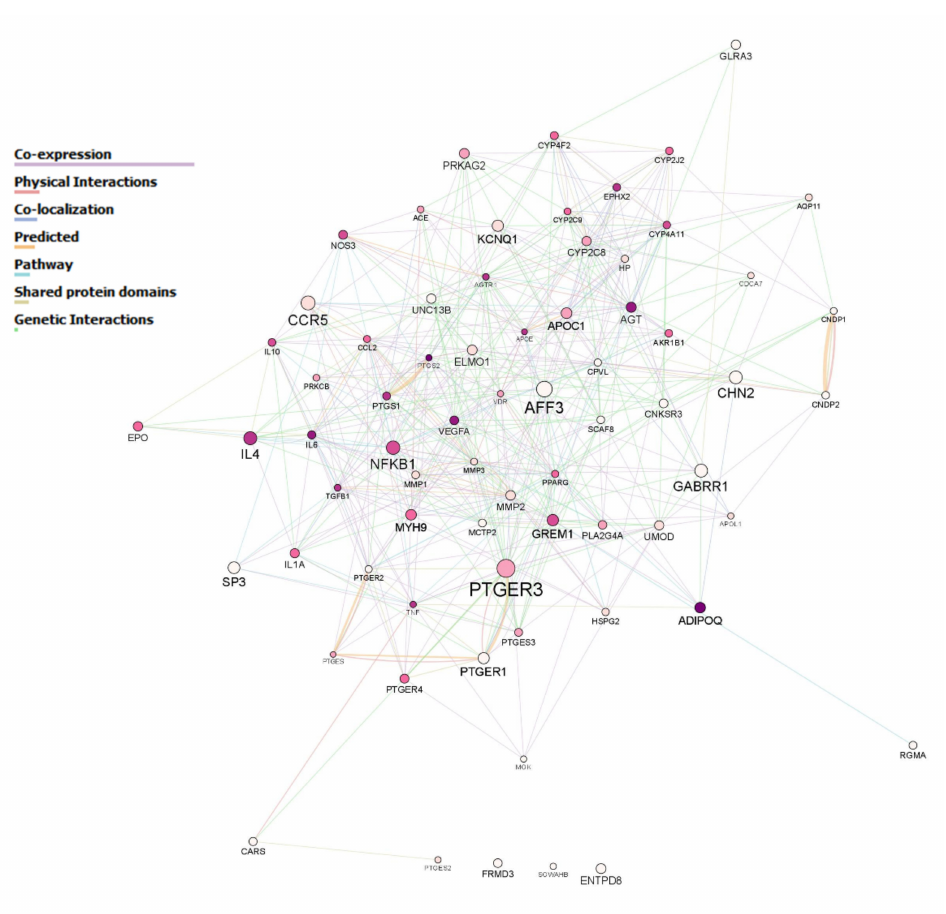
Figure 2. Seventy candidate genes included in the study. Each node corresponds to a gene. Their sizes are related to the number of variants harbored in the gene locus identified in the entire population. The more variants, the larger the size. The color of the node corresponds to the number of major biological pathways in which the gene participates; the darker the color, the more pathways are involved. White nodes represent genes that did not participate in any of the most common biological routes observed for the 70 genes according to the GO annotation for biological processes. The different color-coded interactions are specified in the